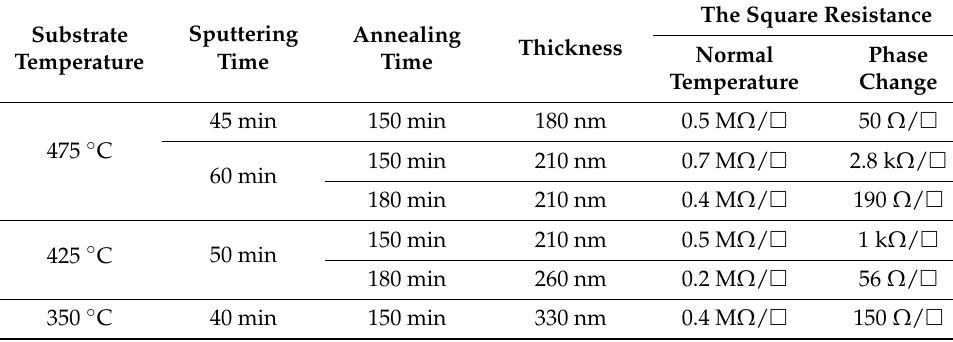
Table 1. The conditions and result of magnetron